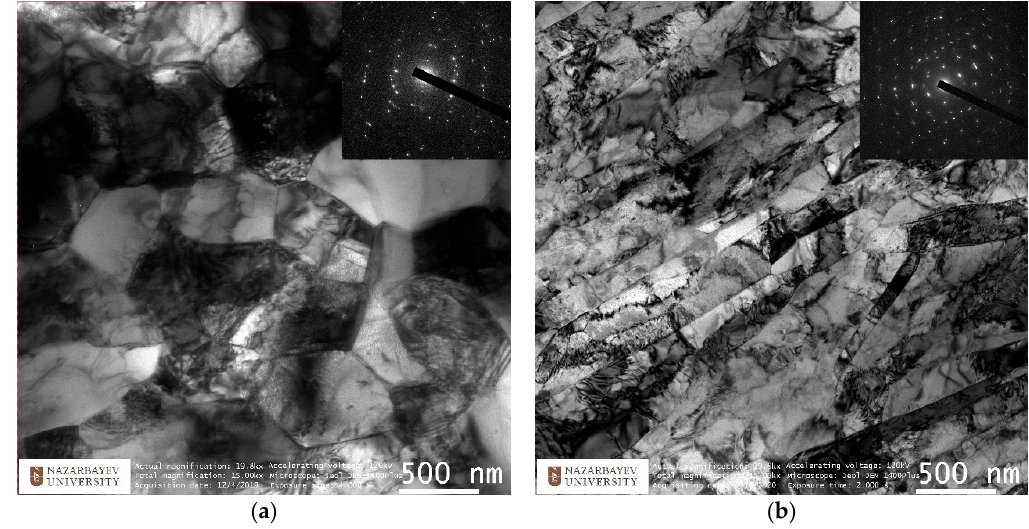
Figure 11. Structure of Zr-1%Nb alloy after radial-shear rolling (x): ( a )—periphery, ( b )—center. The electron images represent equiaxed dislocated fine grains with sizes from 500 to 1000 nm.